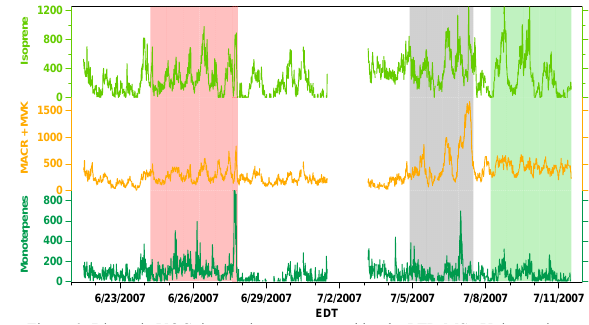
Figure 3. Biogenic VOC time series, as measured by the PTR-MS. Units are in pptv. Red, black and green shaded periods refers to different air mass episodes: Processed Air, Detroit Air, and Sulfate and Biogenic Air, respectively.